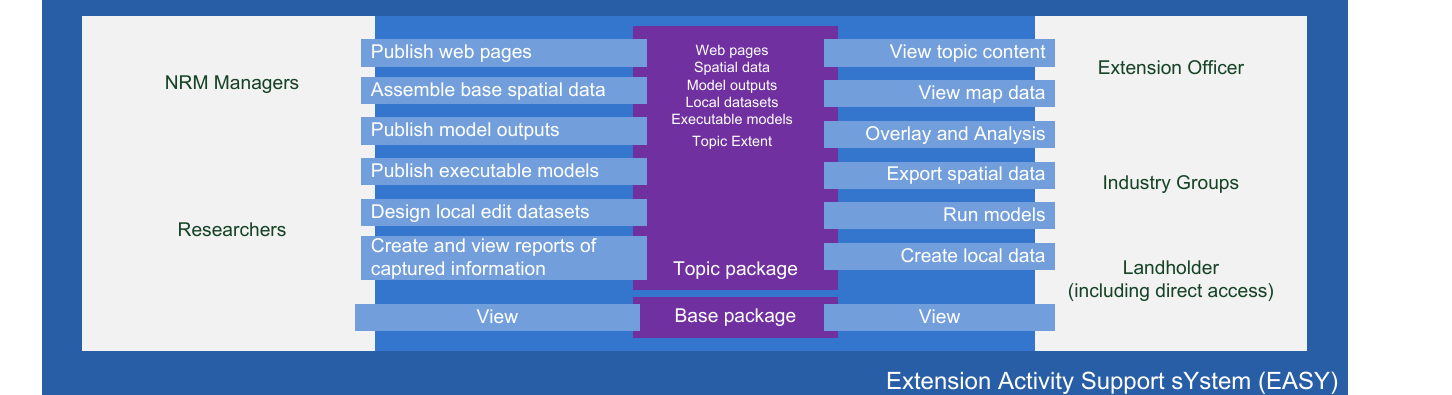
Figure 2. EASY functional areas and user groups based on topic package concept established to support industry customisation. For example, topic package for dairy, livestock or horticultural industries.